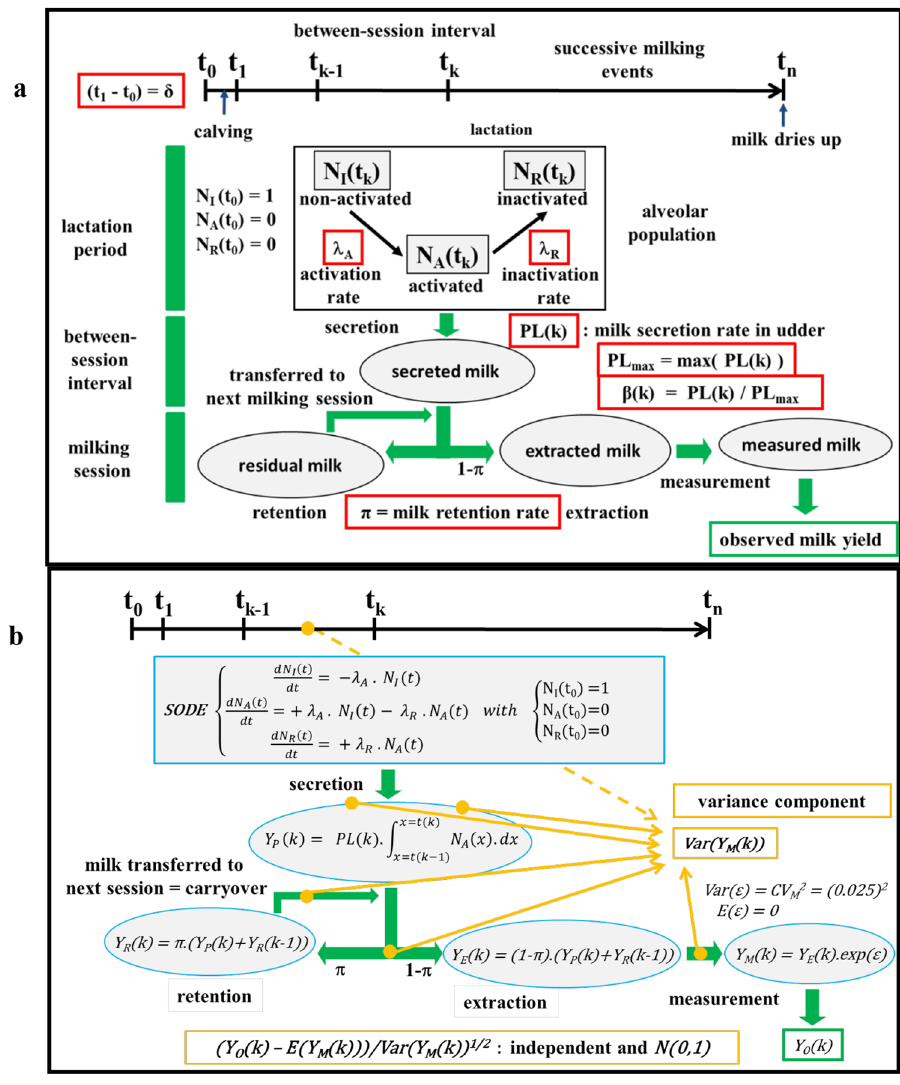
Figure 1. Model components. ( a ) Biological model and parameters and ( b ) mean and variance